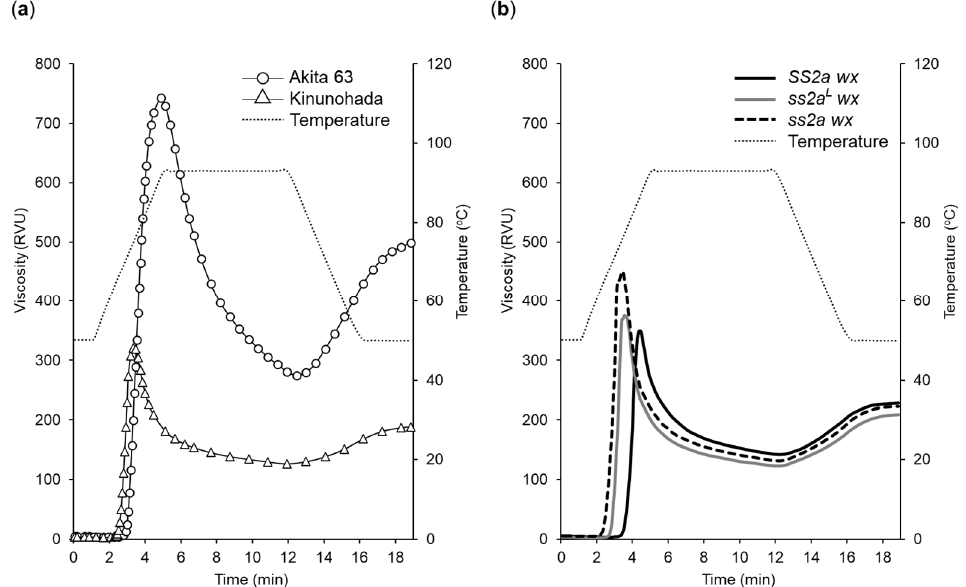
Figure 6. Pasting properties of endosperm starch suspension in water, as analyzed with an rapid visco analyzer (RVA). ( a ) Viscogram of Akita 63 and Kinunohada. ( b ) Comparison of the viscograms of SS2a wx, ss2a L wx, and ss2a wx. Data represent the average of three replicates. Parameters of pasting properties are shown in Figure S4a. Comparison of the viscogram of Kinunohada with that of near isogenic rice lines (NILs) is shown in Figure S4b.